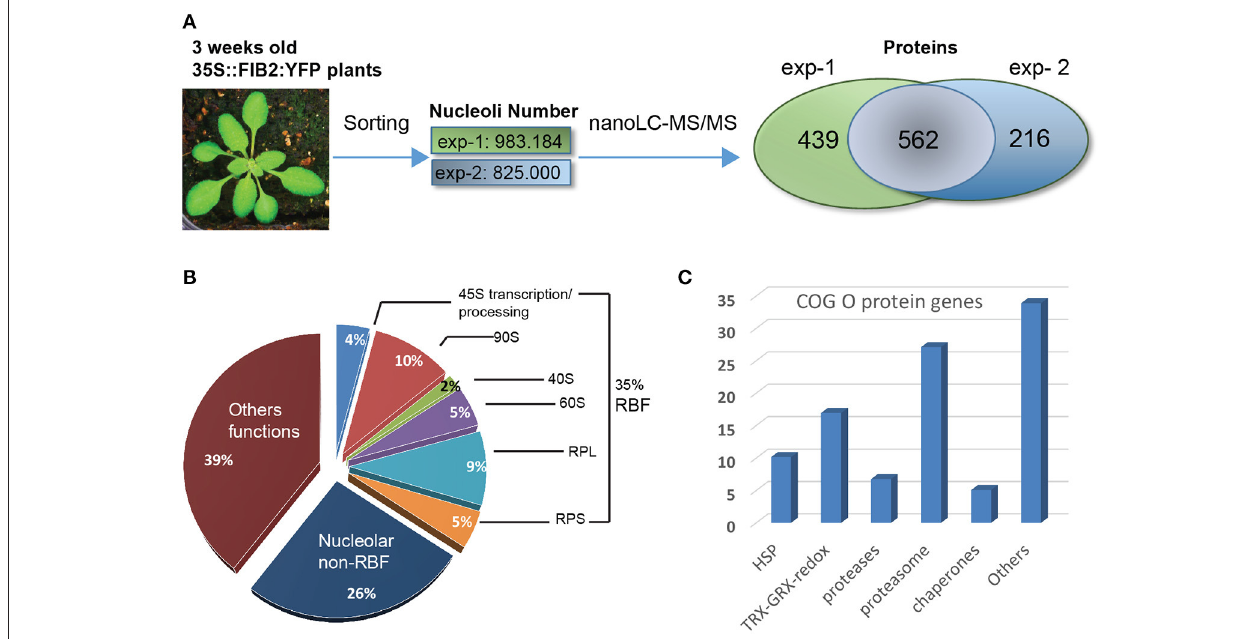
FIGURE 1 | Proteomic analysis of A. thaliana nucleoli. (A) Nucleoli extraction and nanoLC-MS/MS analysis from biological uplicates: exp-1 and exp-2. From left to right: picture of a 3 week-old leaves from WT FIB2:YFP A. thaliana , number of sorted nucleoli per experiment and Venn Diagram showing the number of proteins identified in exp-1 (1,001), exp-2 (778), and both (562). (B) Pie graph shows categories of proteins found in the nucleolar fractions. Proteins are classed in three major categories: Ribosome Biogenesis Factors or RBF (35%), nucleolar non-RBF (26%) and others functions (39%). RBF are detailed in sub-categories: 45S transcription/processing (4%), 90S processome (10%), 40S (2%) and 60S (5%) assembly factors, large (9%) and small (5%) ribosome sub-units (RPL and RPS). (C) The histogram shows the percentage of nucleolar proteins found in the Cluster of Orthologous Group (COG)